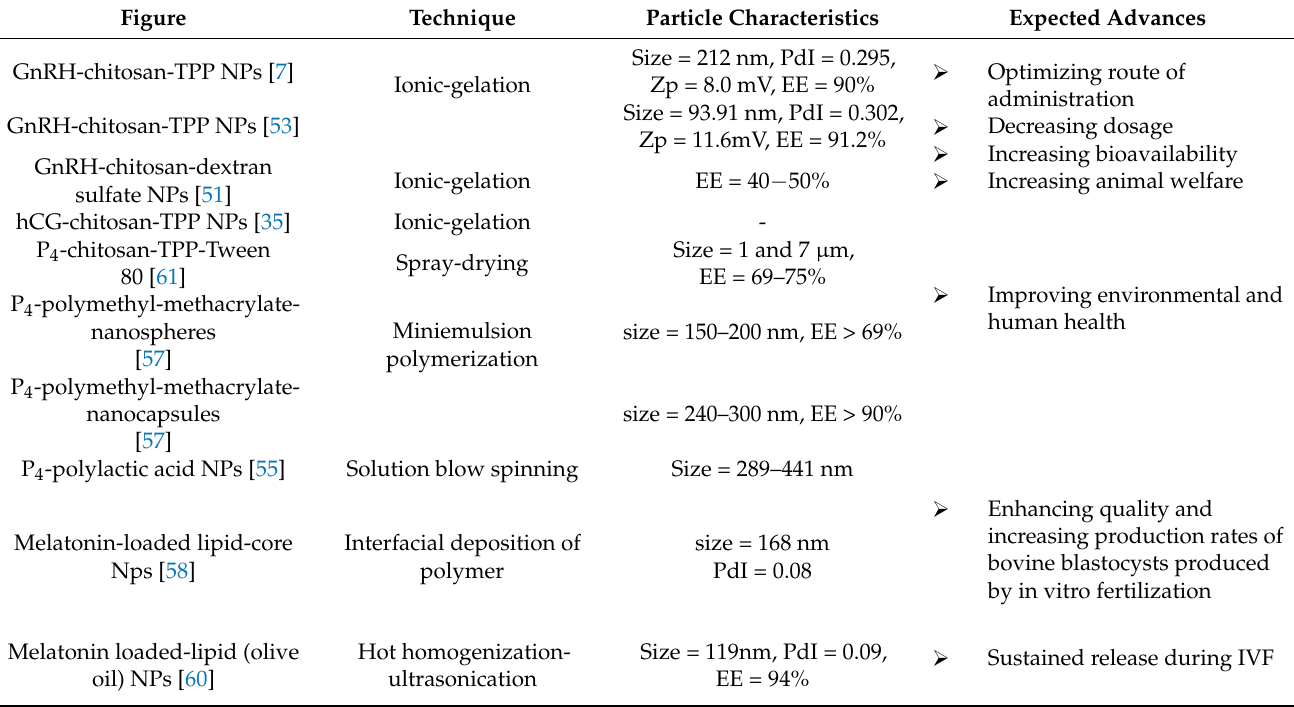
Table 1. Characteristics and expected advances by the implementation of nanotechnologies in the use of reproductive hormones for farm animals’ reproductive management. Figure Technique Particle Characteristics Expected Advances